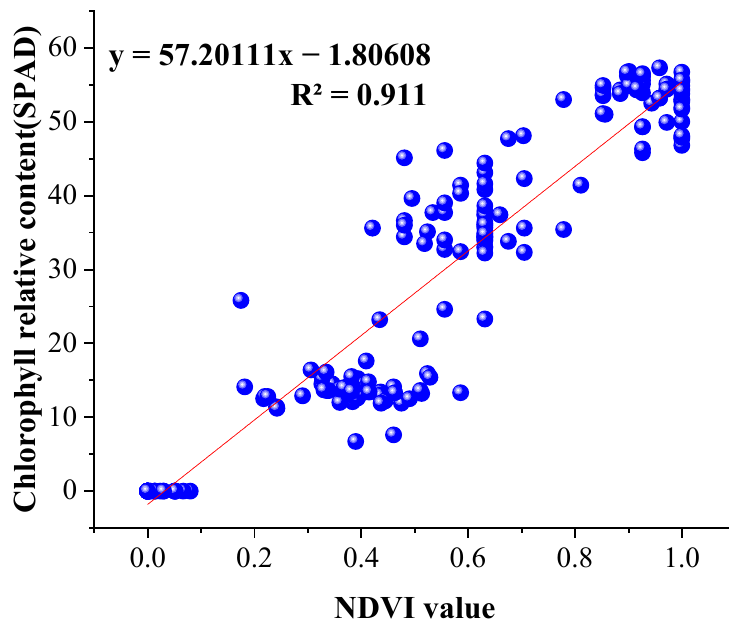
Figure 18. Correlation between the NDVI and NPSDI.